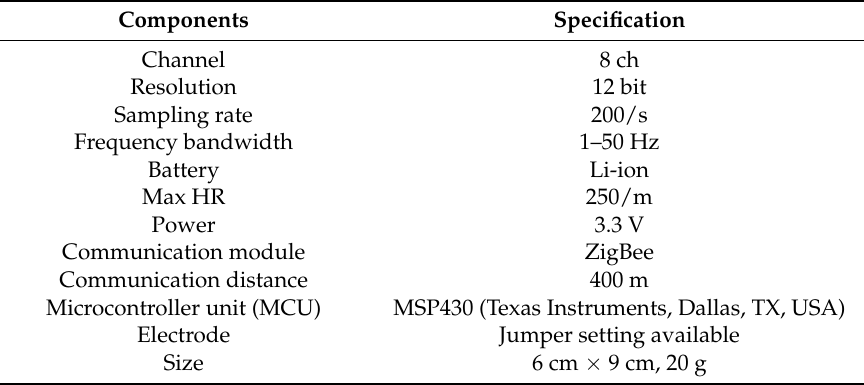
Table 1. Specifications of the sensor node.